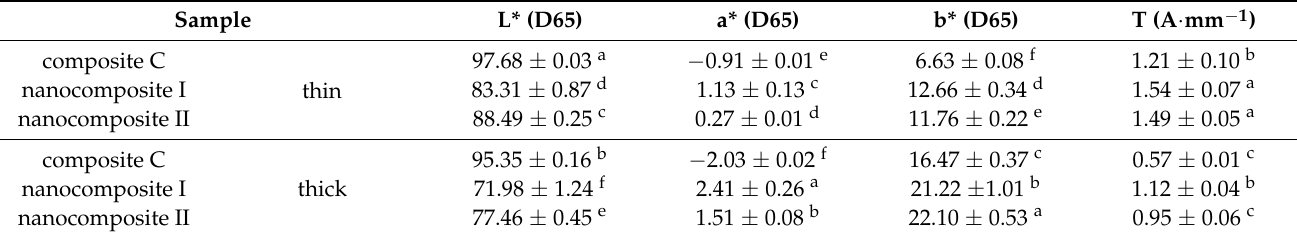
Table 5. Colour parameters and transparency of